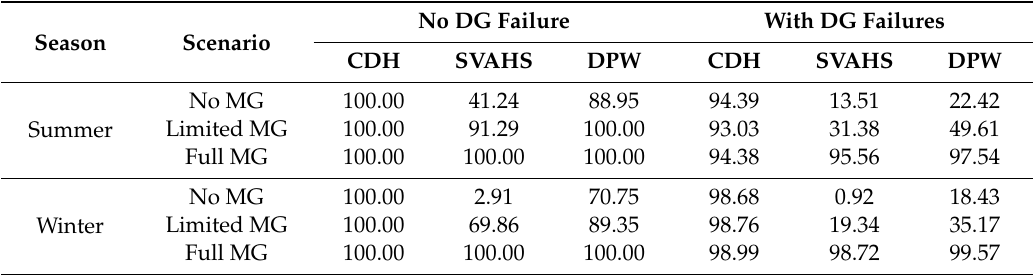
Table 9. Mean survival rates of the system with CDH PV in 7 days outages.